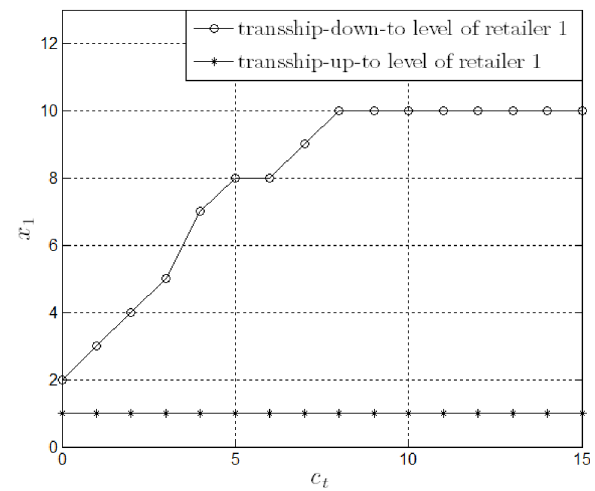
Figure 2. Relation between transshipment and transshipment